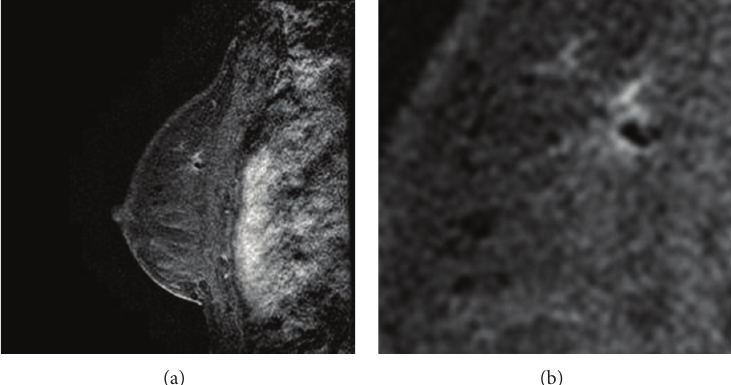
Figure 3: (a) Postclip placement MRI demonstrates a signal void (clip) within the enhancing nodule, confirming that the appropriate lesion was biopsied under ultrasound. (b) Coned down, magnified view of the same